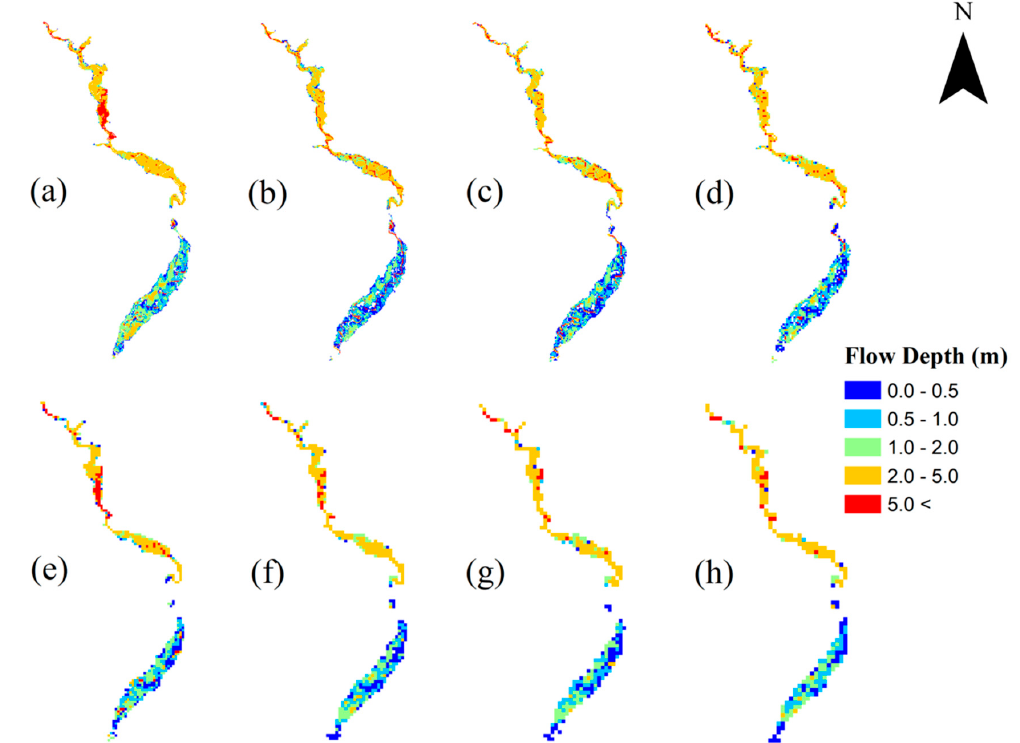
Figure 7. Distribution of inundation flow depths for: ( a ) reference model at 150 m and natural cross sections; as compared to upscaled flood models synthetic rectangular cross section at resolution of: